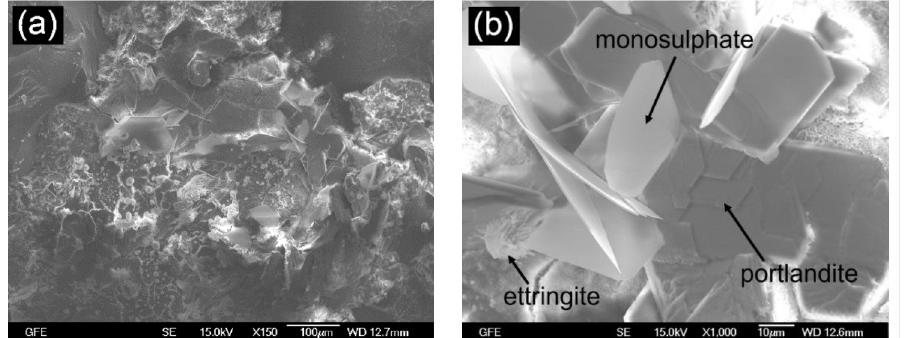
Figure 12. SEM micrographs (2 mm depth, ( a ) overview and ( b ) detail) of concrete with CEM II/B-S 42.5 N (w/c = 0.50) stored for 182 d at 5 ◦ C in Na 2 SO 4 solution with 6000 mg SO 4 2 −